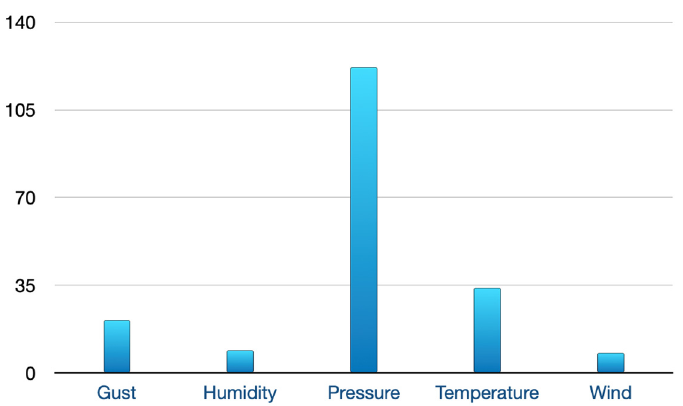
Figure 7. Social media postings matching the sosa observable property.